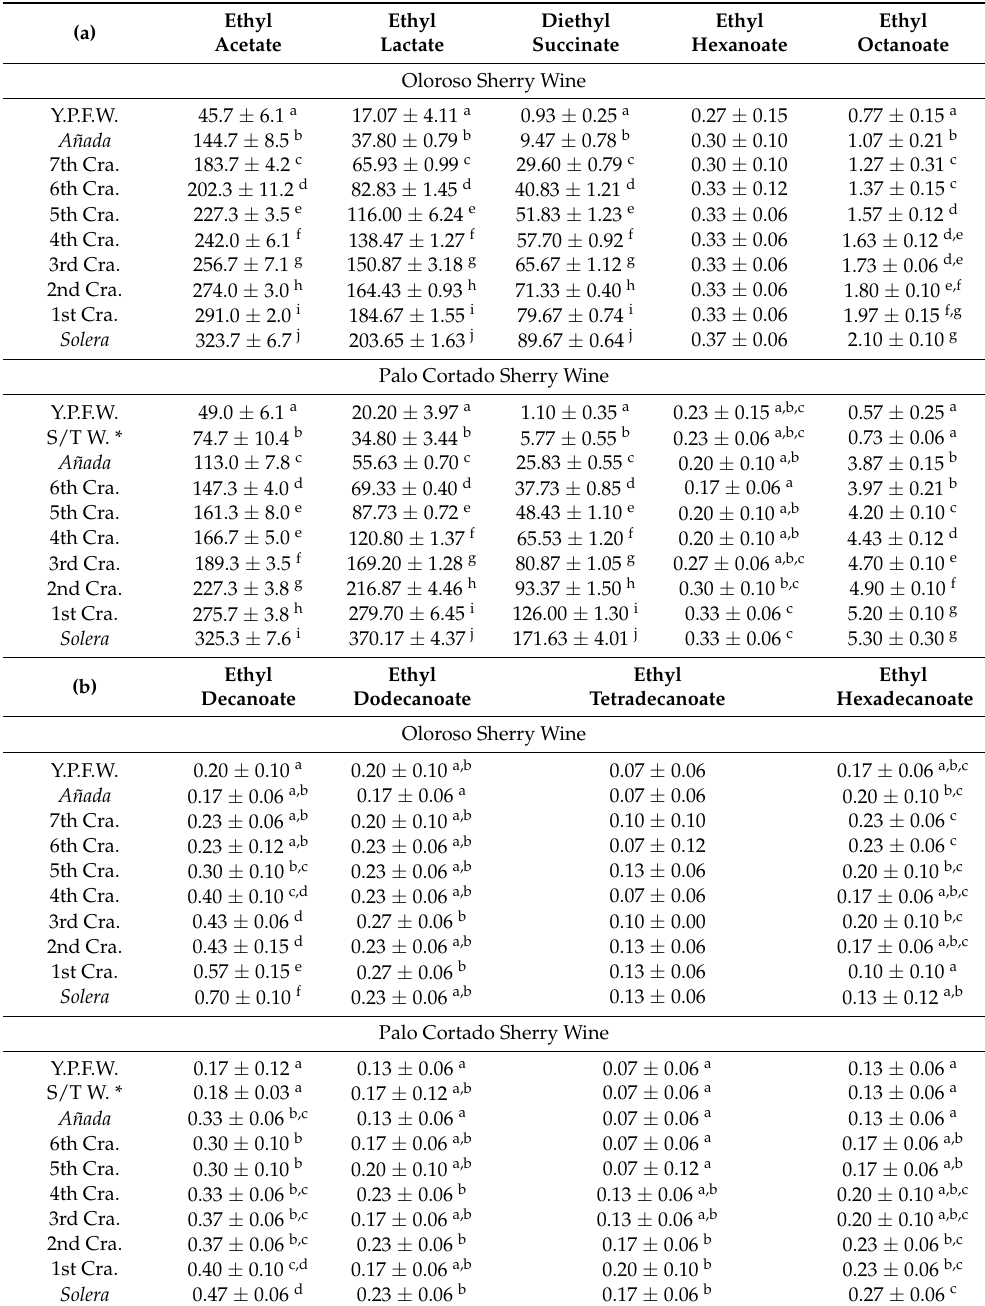
Table 7. (a) Ethyl acetate, ethyl esters of organic acids and ethyl esters of fatty acids in mg/L in the Oloroso and Palo Cortado Sherry wines studied. (b) Ethyl esters of fatty acids in mg/L in the Oloroso and Palo Cortado Sherry wines